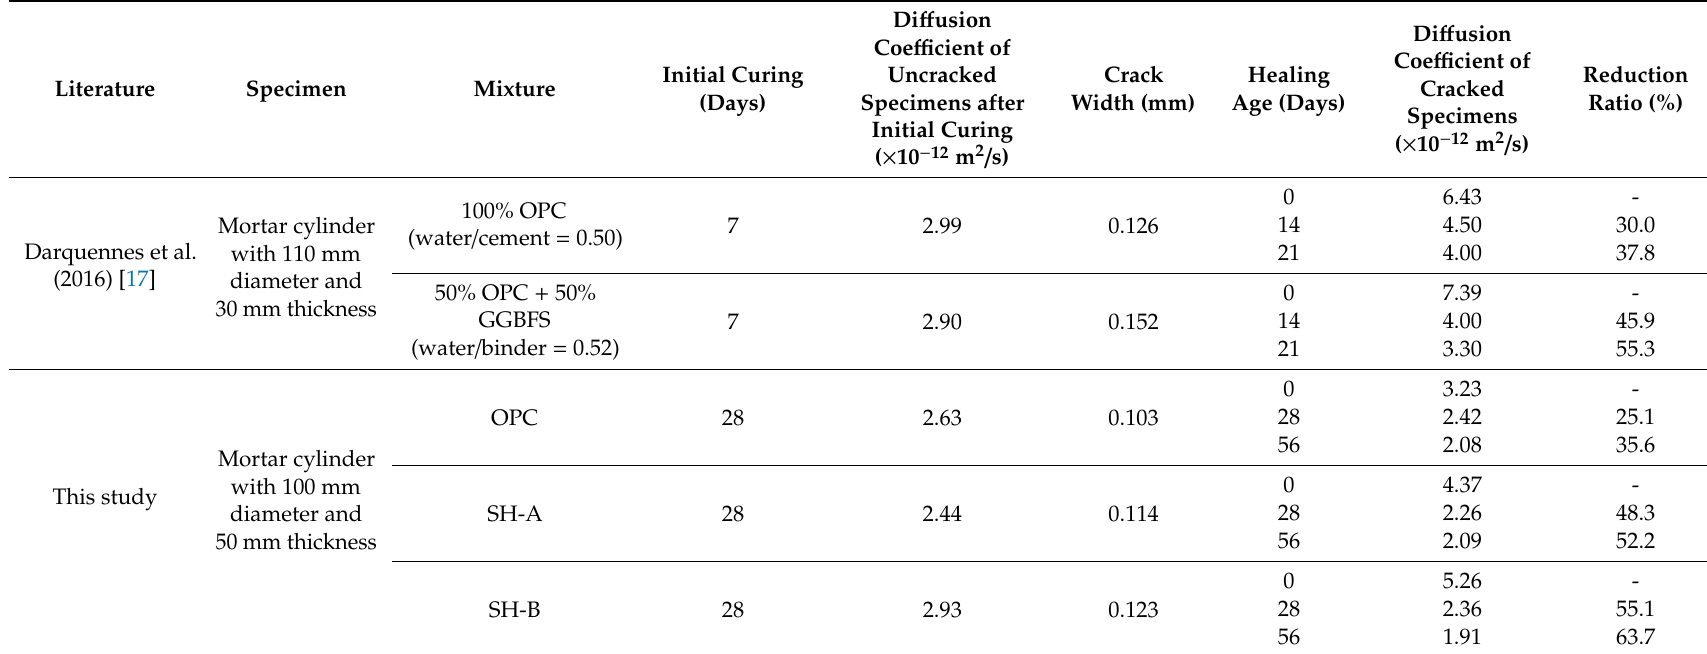
Table 4. Comparison of the di ff usion coe ffi cients with literature